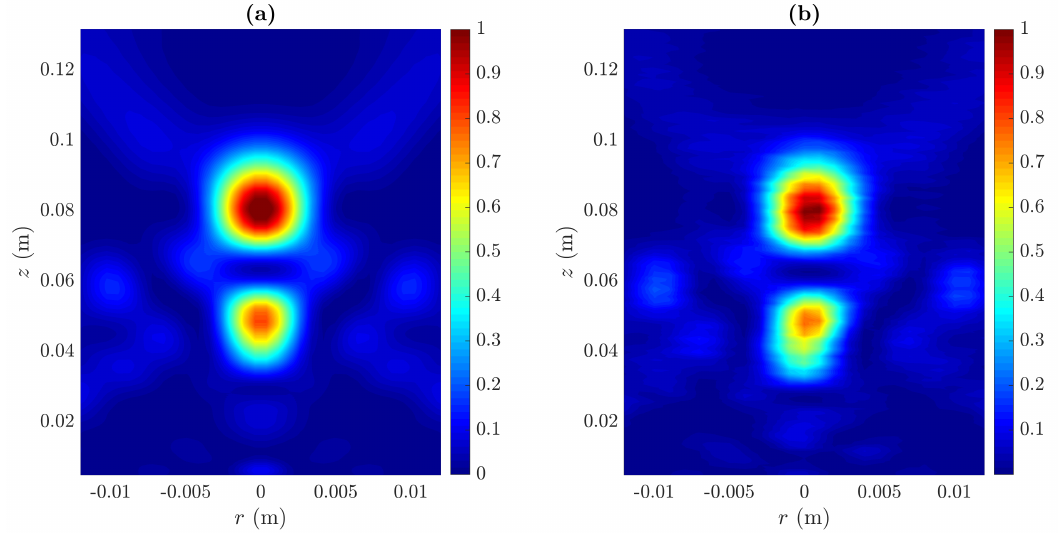
Figure 5. ( a ) Manufactured BiFZP lens made of brass and ( b ) the experimental set-up with the lens.